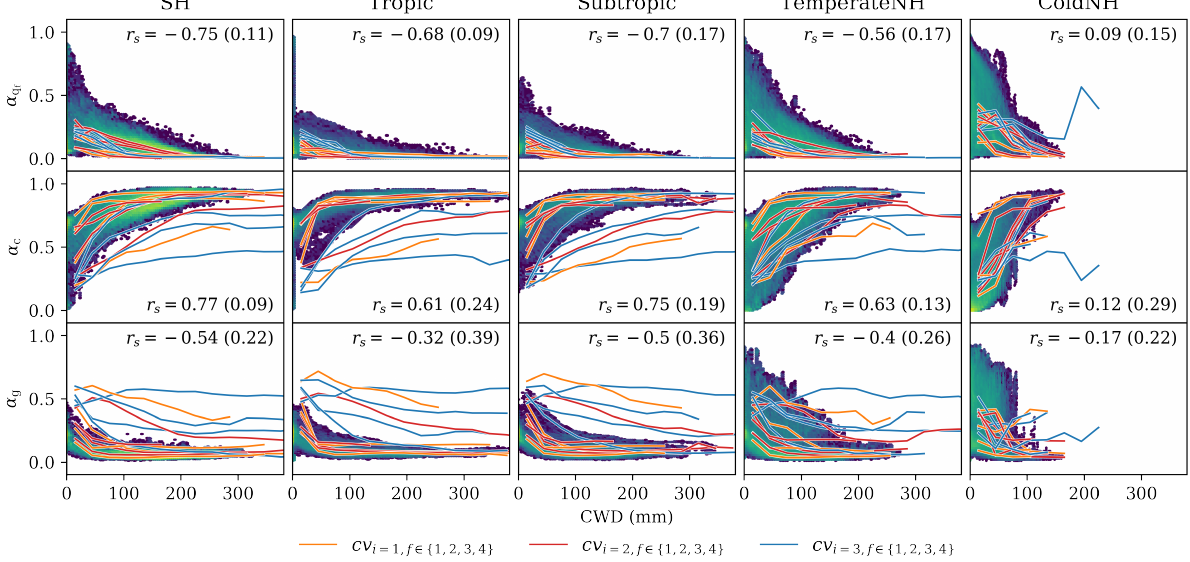
Figure 5. Density plot of the soil cumulative water deficit (CWD) versus the liquid water input ( w inp ) partitioning fast runoff fraction ( α q ), soil recharge fraction ( α c ), and groundwater recharge fraction ( α g ). The fractions define how much of w inp goes into the f respective fluxes. The relationships is quantified using the mean Spearman’s rank correlation coefficient (r s ) over all folds, the standard deviation is shown in brackets. For the density plot, on single fold ( cv i =1 ,f =1 ) was used. The lines represent the binned median, i.e. , the median of the fractions over a range of CWD values, of the individual cross-validation test sets. The lines are colored by cross-validation run index, i.e. , lines with the same color come from one cross-validation run and represent the same